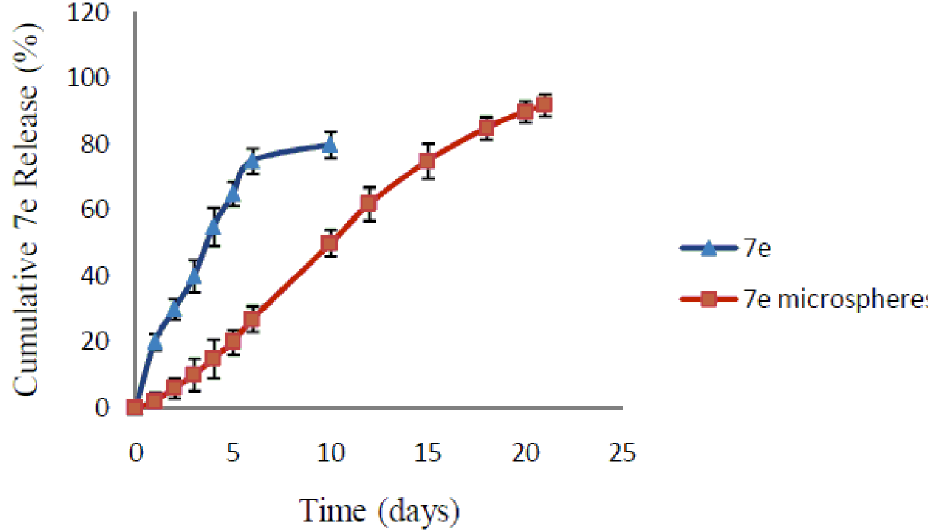
Fig 13. Cell viability of A549 cells incubatedwith free 7e (A) and 7e-loadedmicrospheres (B) at 0.8, 1.6, 3.13, and 6.25 μ M drug concentrations after 24, 72, and 120 h incubation time.